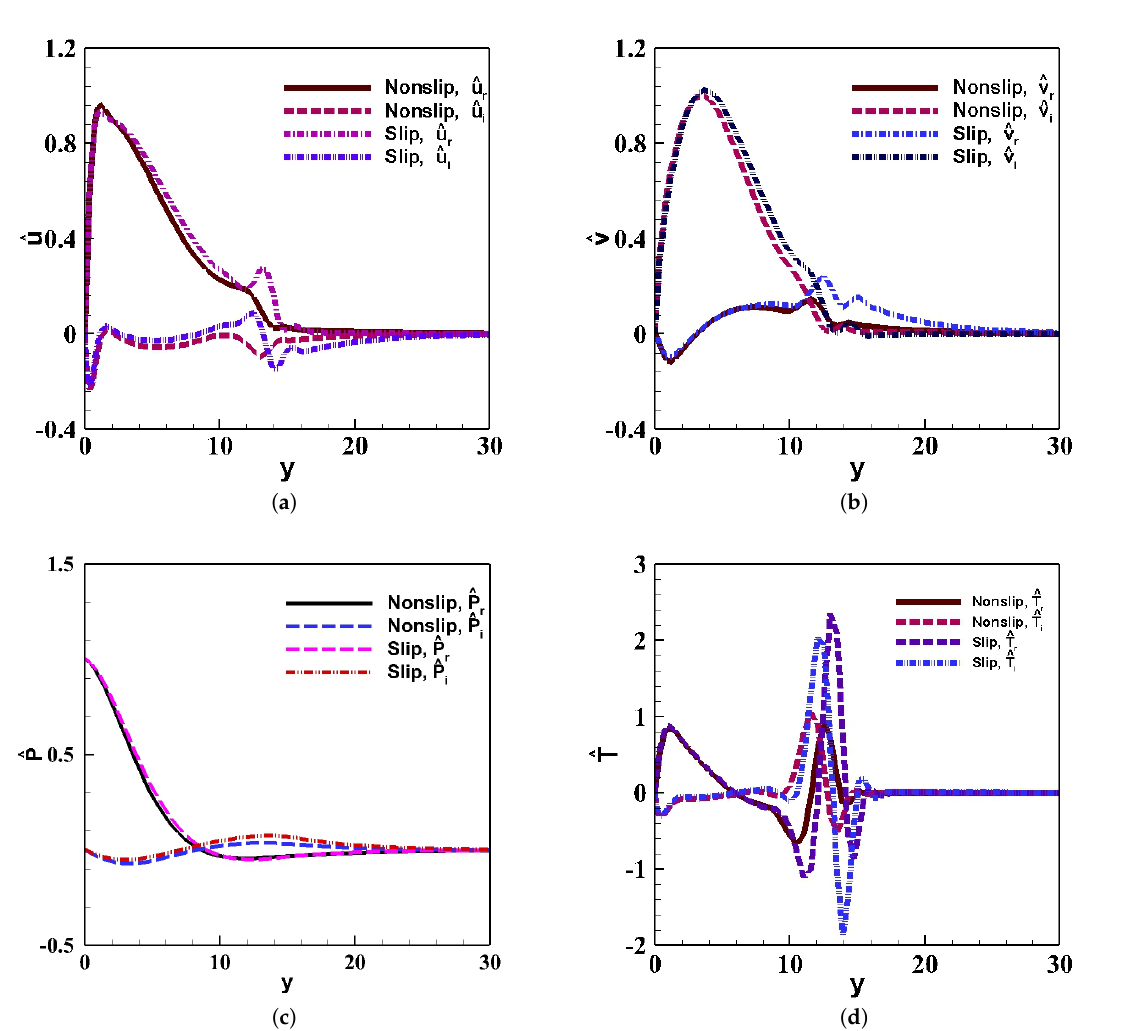
Figure 5. Mode No. 1 related perturbation eigenvectors. Ma e = 4.5, x = 0.139 m, and R =